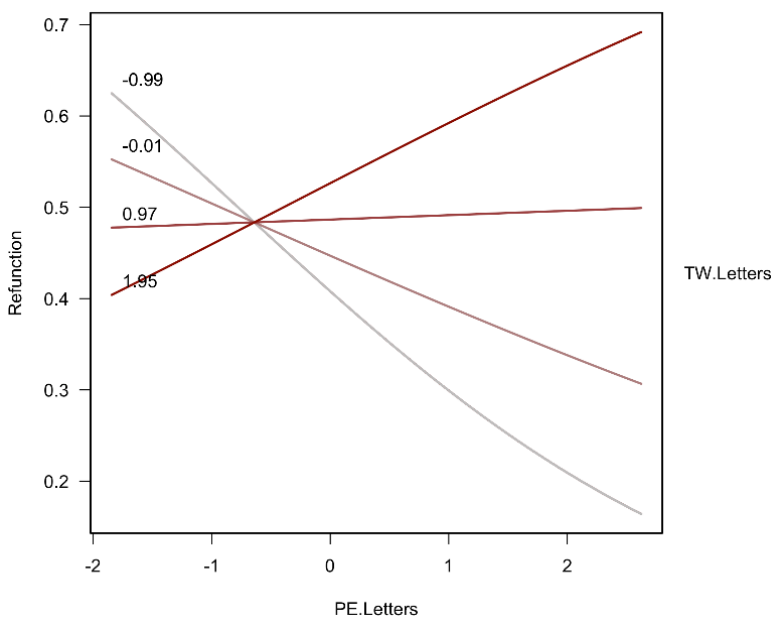
Figure 4. Effect plot for TW.L ETTERS :PE.L ETTERS (interaction effect).